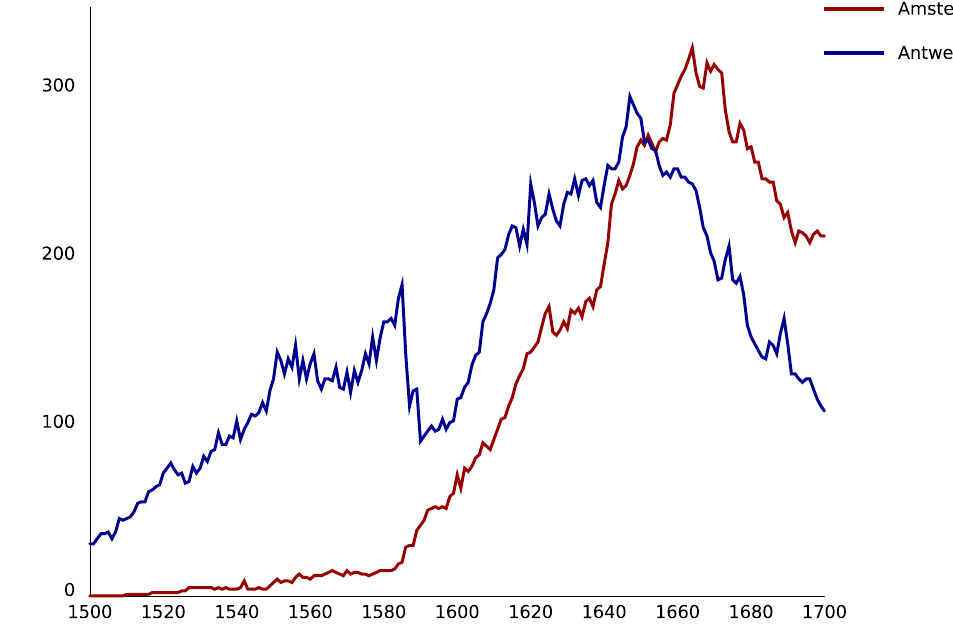
Figure 3. Number of painters active in Antwerp and Amsterdam, 1500–1700. Source: ECARTICO, date accessed 10 April 2019.